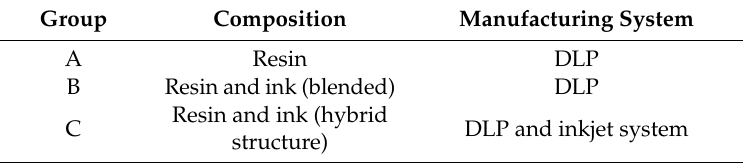
Table 2. Compositions and systems used for the manufacturing of each testing group. Group Composition